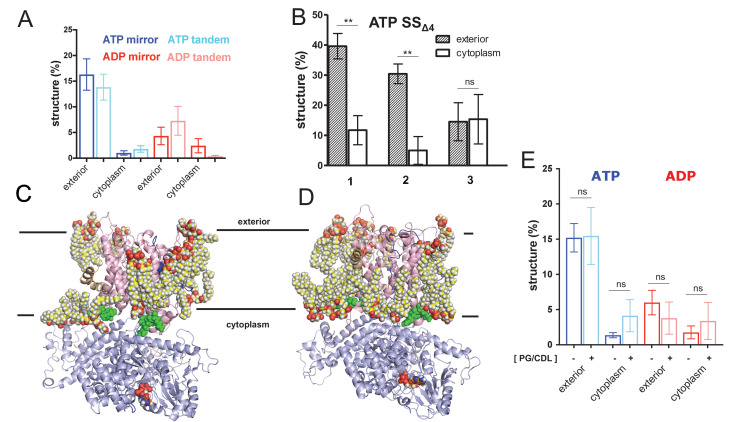
Expanded pre-protein folding data.(A) Comparison of folding data gathered from the pre-protein in a mirrored (ELERQHTFAAFTHQRELE) or tandem (ELERQHTFAELERQHTFA) arrangement. (B) The degree of pre-protein folding in the exterior and cytoplasmic cavities of SecY, for the simulations of SecA-SecYE-PP with a defective signal sequence (SSΔ4), starting at three different snapshots (1 = 90 ns, 2 = 100 ns, 3 = 110 ns). Error bars are s.e.m, and reported significance is from two-tailed t-tests, where p=0.003 and p=0.002; p=0.938 for run 3. (C) View of SecA-SecYE complex with ATP following coarse-grained simulation and back mapping to an atomistic description. Show in spheres are acidic lipids (i.e. phosphatidylglycerol and cardiolipin) in contact with the complex. The other lipids and solvent have been omitted for clarity. (D) As panel C, but for the ADP-bound complex. (E) Comparison of folding data from systems in a simple (i.e. containing only 1-palmitoyl-2-oleoyl-sn-glycero-3-phosphocholine) membrane (dark blue and red) and a membrane containing acidic lipids (light blue and pink – labelled ‘PG/CDL’). There is no significant impact of lipid composition on pre-protein secondary structure formation; p-values=0.95, 0.06, 0.49 and 0.46 from a two tailed t-test.